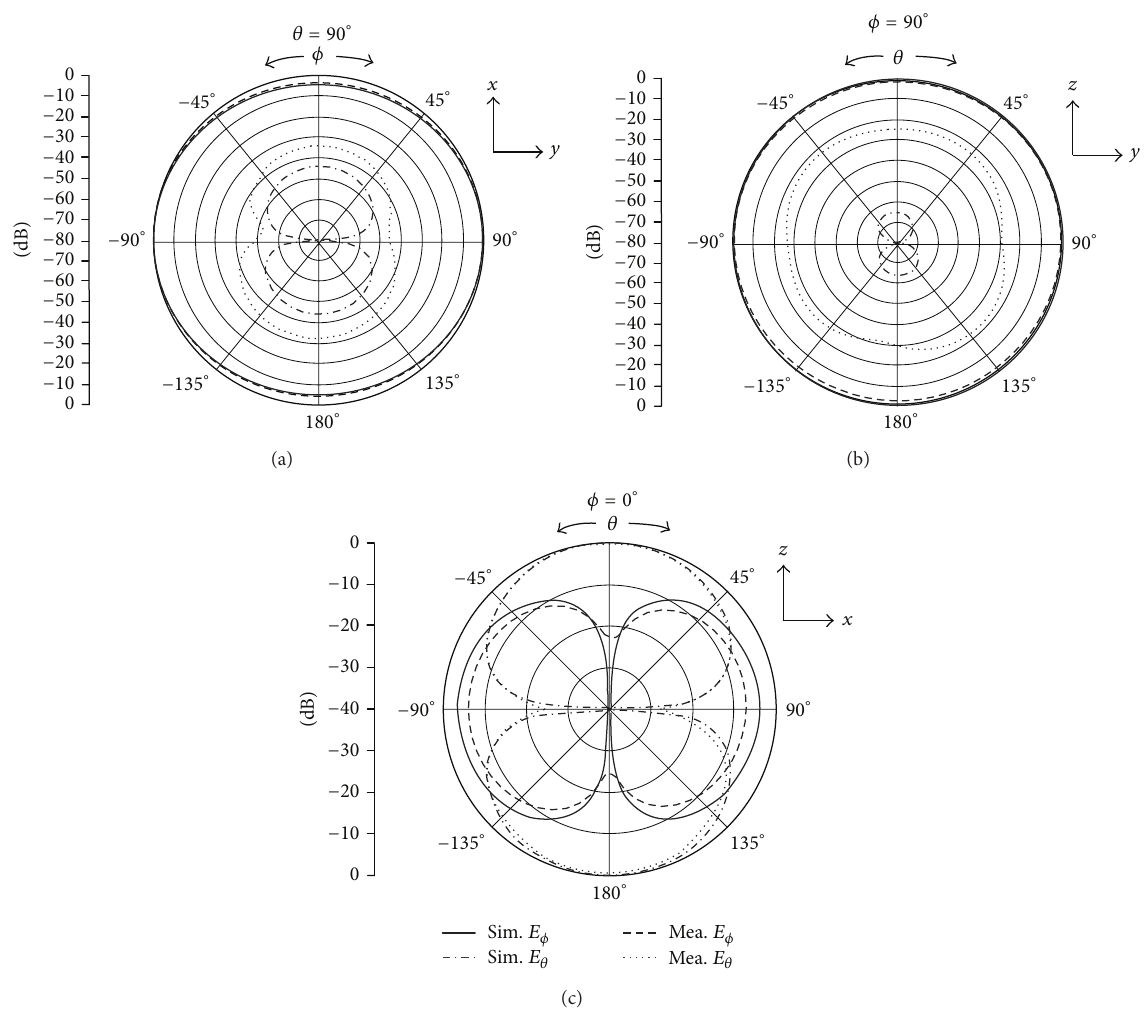
Figure 4: Radiation patterns at 920 MHz in the (a) 𝑥 - 𝑦 plane, (b) 𝑦 - 𝑧 plane, and (c) 𝑥 - 𝑧 plane.